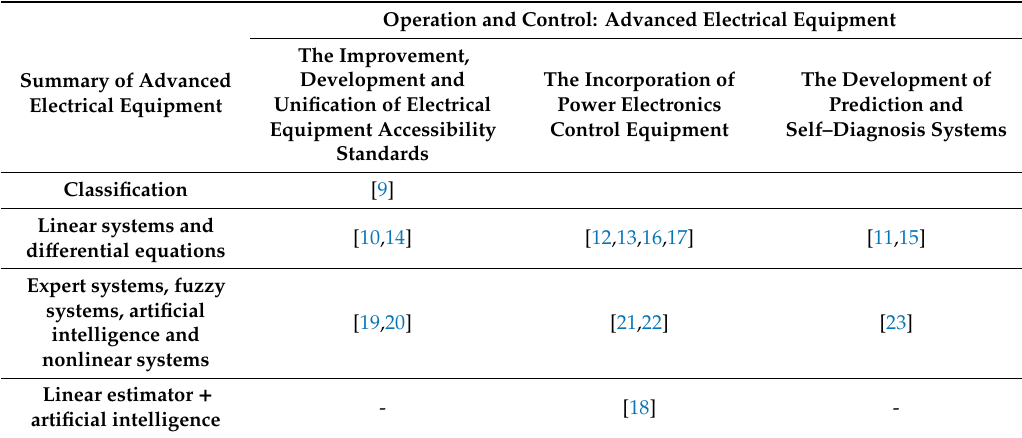
Table 1. Summary of Advanced Electrical